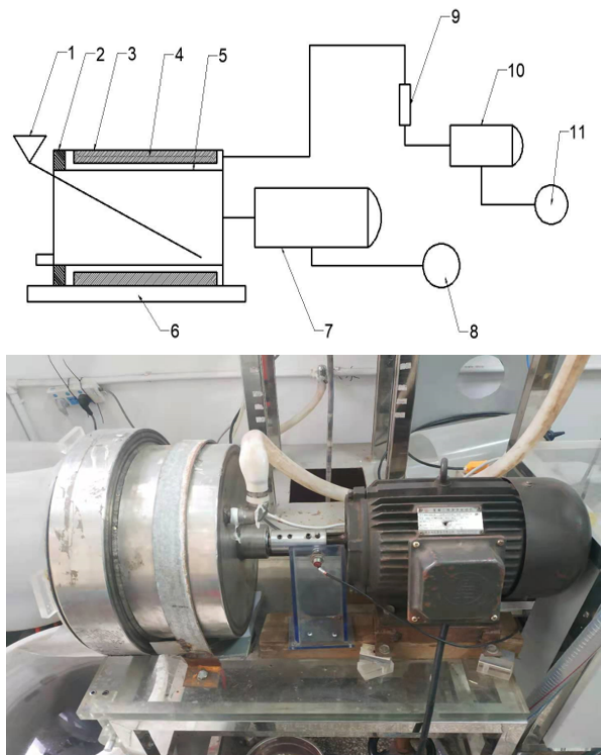
Figure 3. Schematic diagram of the radial turbulent outer-cylinder magnetic separator (1—feed hopper; 2—sealing ring; 3—fixed cylinder; 4—magnetic system; 5—sorting cylinder; 6—frame; 7— motor; 8, 11—frequency converter; 9—flow meter; 10—booster